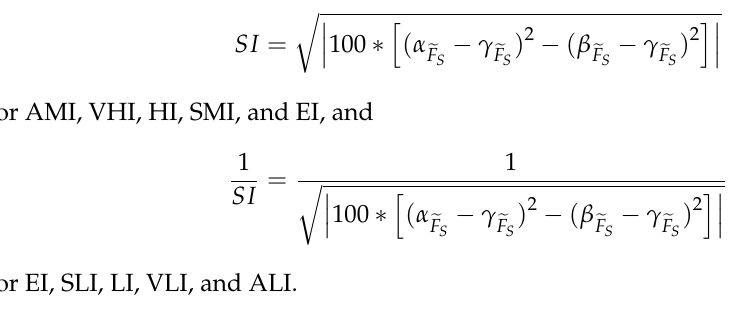
Table 3. SF-AHP linguistic scales used for the pairwise